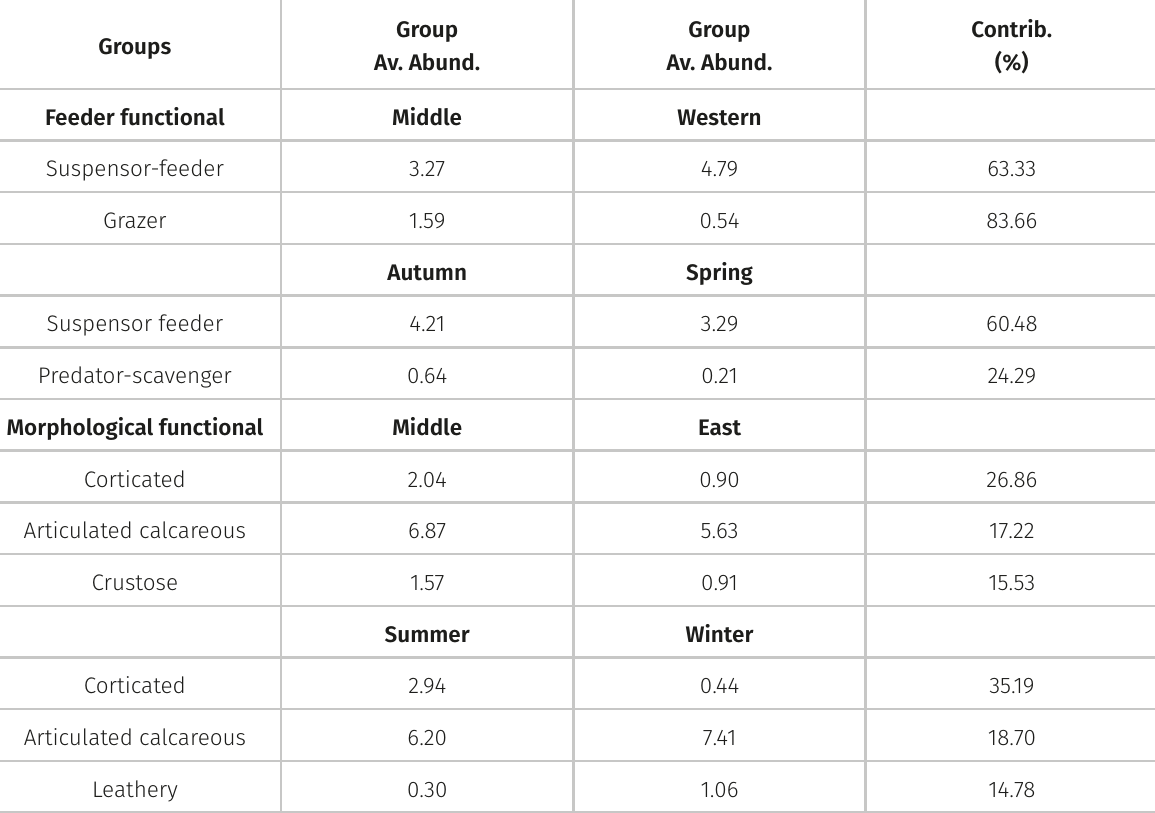
Table IV. SIMPER test showing morphological and feeder functional groups that most contribute to dissimilities.